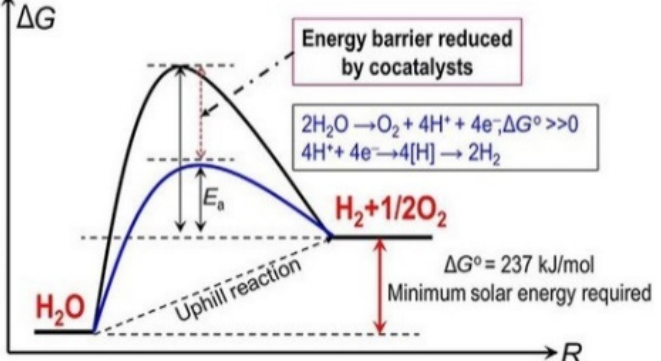
Figure 19. Schematic description of the functions of cocatalysts from [232], with permission of the American Chemical Society.